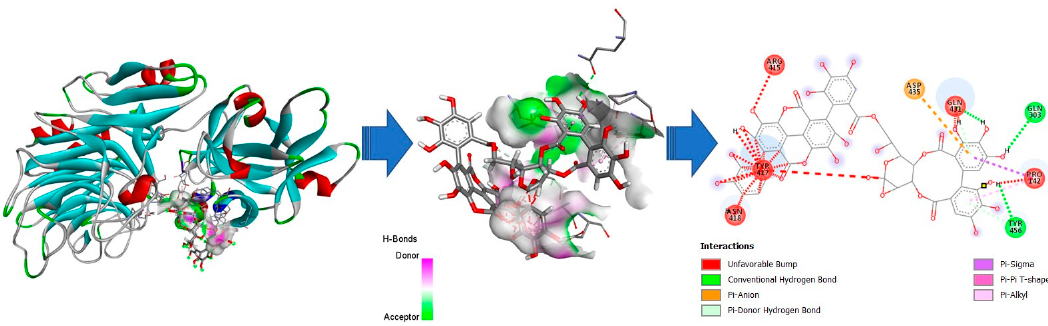
Figure 7. Docking analysis for the interaction between EAH 2 and punicalagin. The ligand-binding site residues are: PRO142, GLN303, ARG415, TYR417, ASN418, GLN431, ASP435, and TYR456.